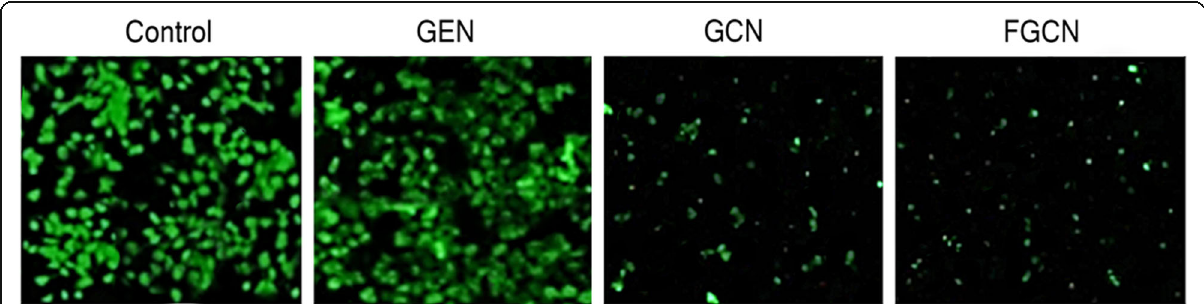
Fig. 7 Live/dead assay of HeLa cancer cells after treatment with GEN, GCN, and FGCN. The green fluorescence indicates the live cells